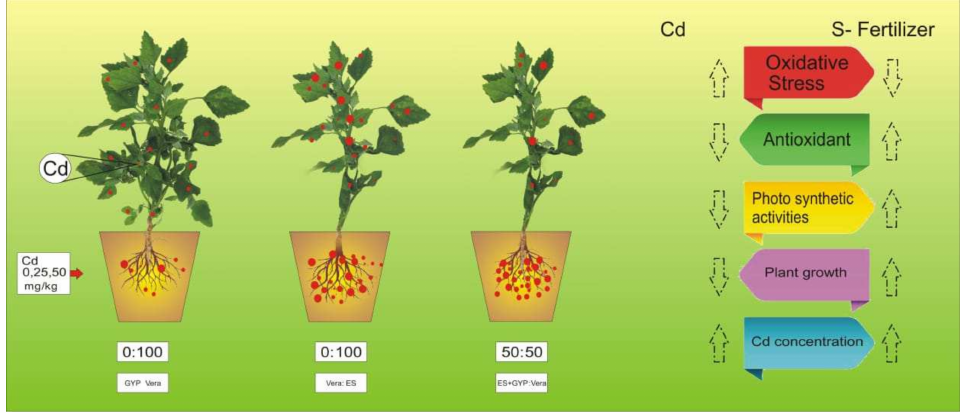
Figure 9. Schematic presentation of Cd toxicity in S. nigrum under the application of S-fertilizers (Gyp, ES and